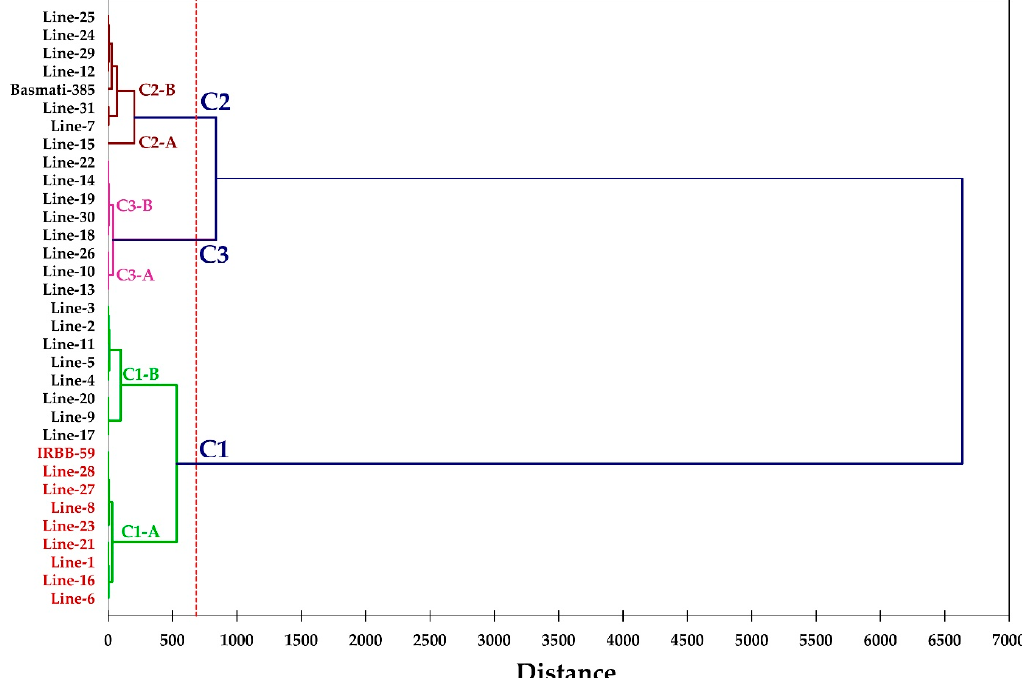
Figure 9. Phylogenetic tree constructed on the basis of percent diseases incidence.